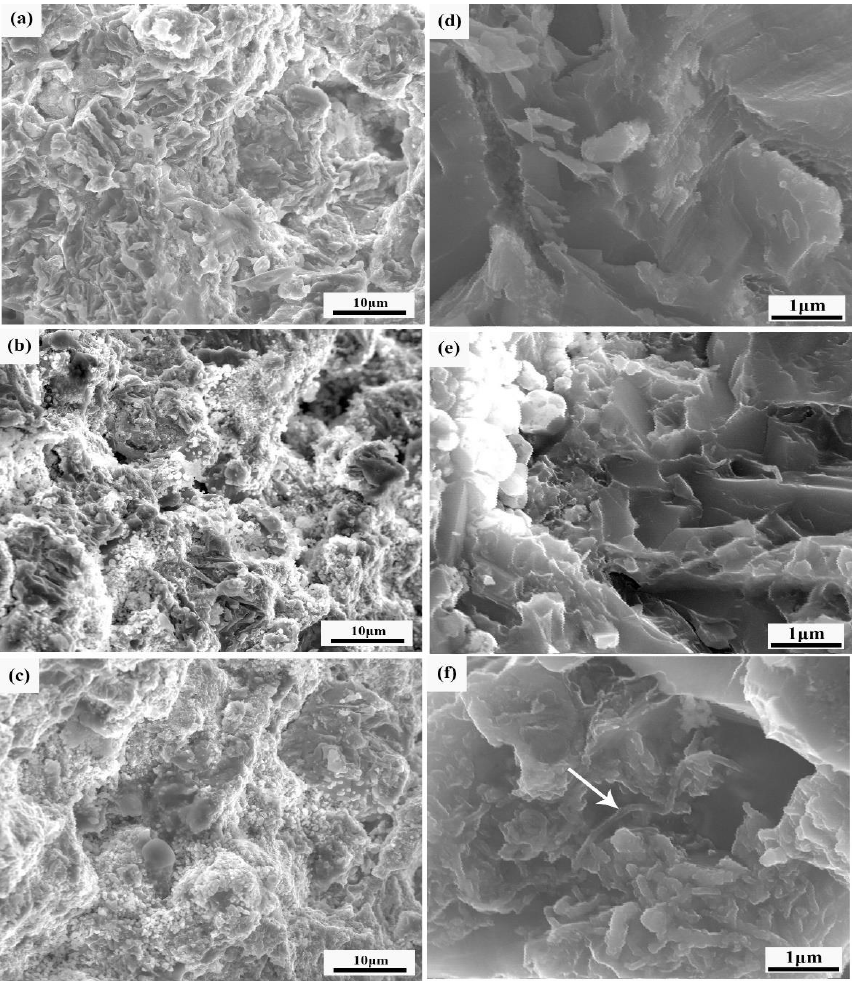
Figure 5. FESEMfracture morphology of composites with different CNT contents ( a , d ) 0%; ( b , e ) 0.5%; and ( c , f ) 1.0%.